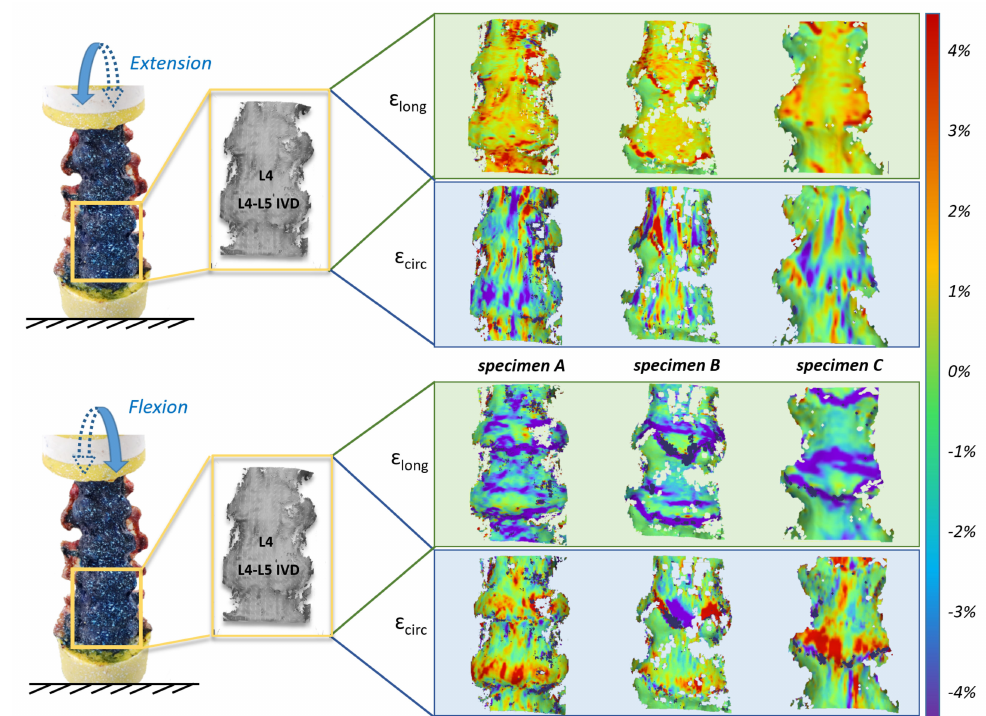
Figure 3. Full-field strain maps obtained from the DIC analysis for all the specimens at the peak load ( ± 7.5 Nm). The longitudinal ( ε long ) and circumferential ( ε circ ) percent strain are reported for extension (top) and flexion (bottom). The color maps show the non-uniform distribution of